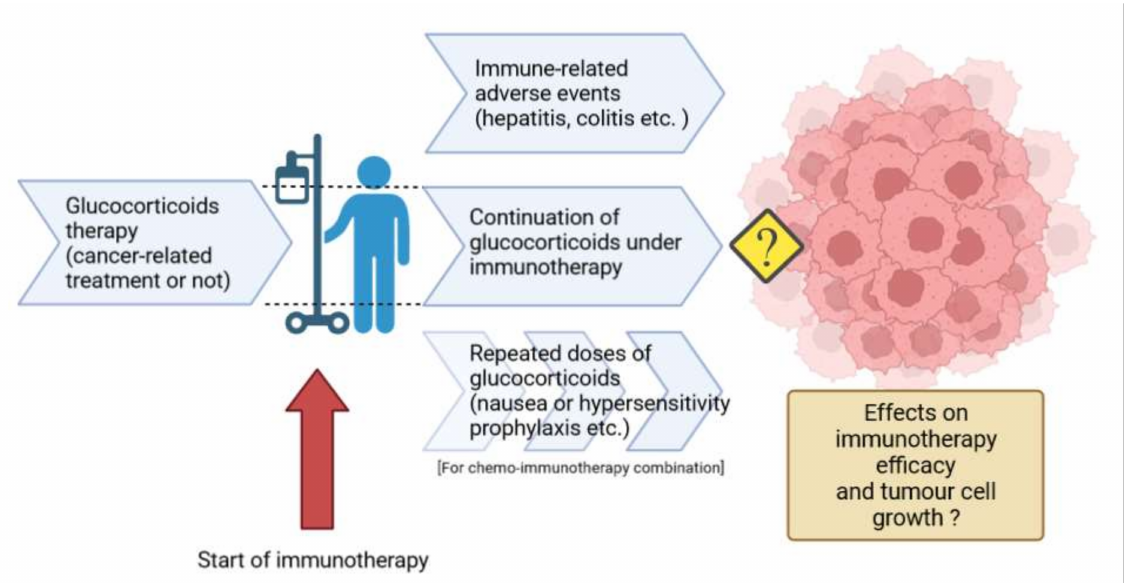
Figure 4. Challenge of glucocorticoid therapy in patients receiving immunotherapy (created with